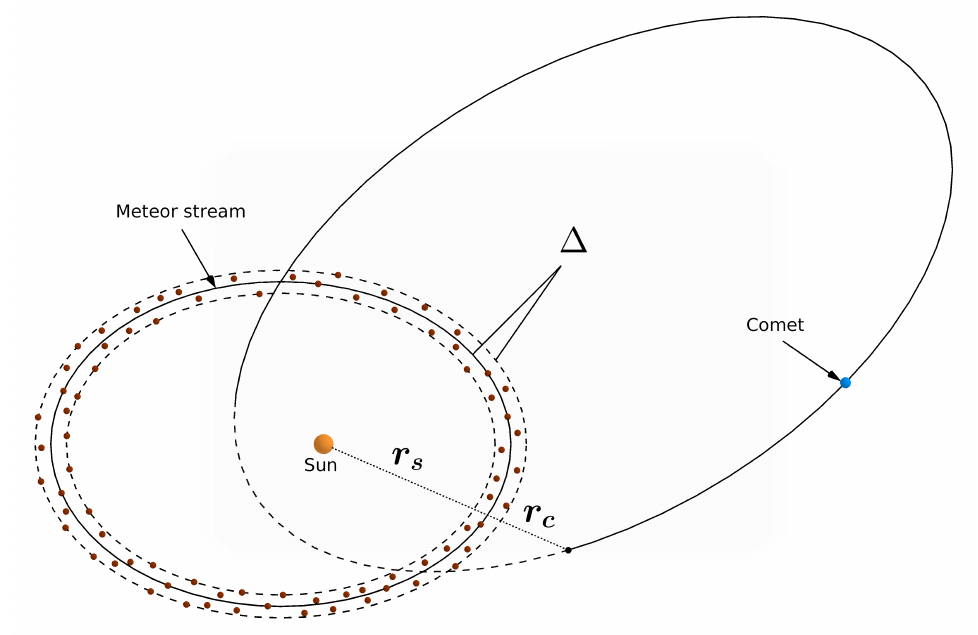
Figure 1. To the definition of the parameters r s and r c